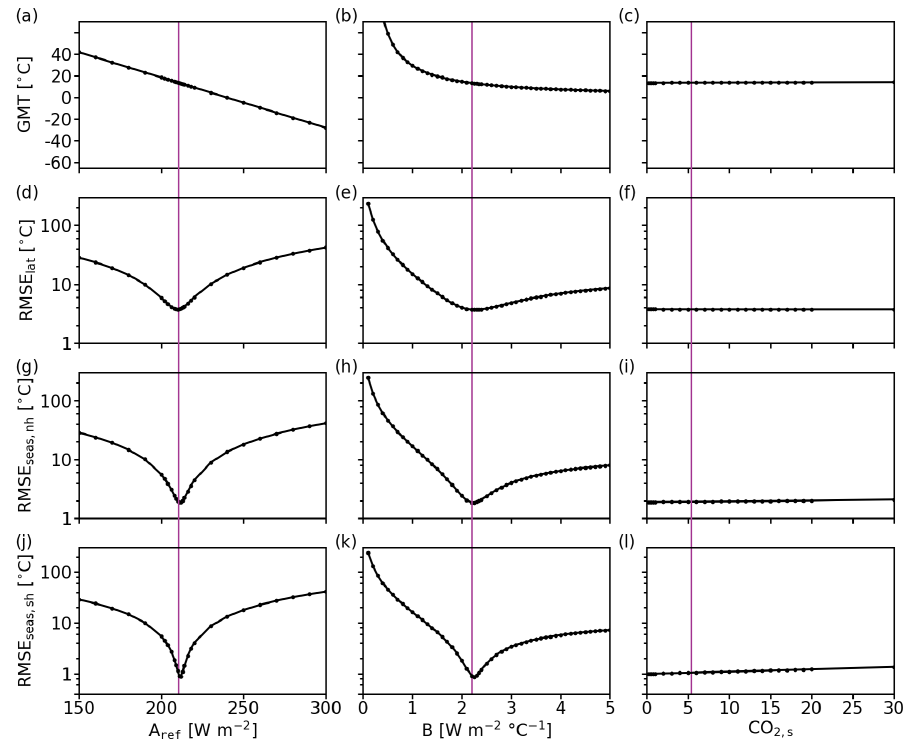
Figure 9. Effect of changes to the parameterization of the outgoing radiation on the GMT and the RMSEs of the latitudinal (RMSE lat ) and seasonal temperature profiles in both hemispheres (RMSE seas , nh and RMSE seas , sh ) with respect to ERA-20CM reanalysis (Hersbach et al., 2015). (a–c) GMT, (d–f) RMSE lat , (g–i) RMSE seas , nh , and (j–l) RMSE seas , sh . The first column shows results for A ref , the second shows results for B , and the third shows results for CO 2 , s . Simulations and reanalysis cover 1960–1989CE. The simulations used the land, sea, and ice configuration shown in Fig. 1 and constant orbital parameters: eccentricity (ecc = 0 . 016740), obliquity (ob = 0 . 409253), and longitude of perihelion (per = 1 . 796257). CO 2 followed Köhler et al. (2017), and S 0 values followed Coddington et al. (2016). Vertical lines indicate the chosen values after tuning. GMT reaches up to 257 ◦ C for B ; for a better comparison to the other parameters, the full range is not shown in panel (b) . Both A and B affect all tuning metrics, whereas changes in CO 2 , s barely make a difference. Table 6. Tuning metrics GMT, RMSE lat , and RMSE seas for each hemisphere before and after tuning. The metrics were evaluated for the years 1960–1989CE against ERA-20CM (GMT ERA = 13 . 27 ◦ C). The simulations used the land, sea, and ice configuration shown in Fig. 1 and constant orbital parameters: eccentricity (ecc = 0 . 016740), obliquity (ob = 0 . 409253), and longitude of perihelion (per = 1 . 796257). CO 2 followed Köhler et al. (2017), and S 0 values followed Coddington et al. (2016). All metrics except RMSE seas , nh improved with tuning. Metric GMT RMSE lat RMSE seas , nh RMSE seas , sh Before tuning [ ◦ C ] 13 . 73 3 . 74 1 . 92 1 . 03 After tuning [ ◦ C ] 13 .